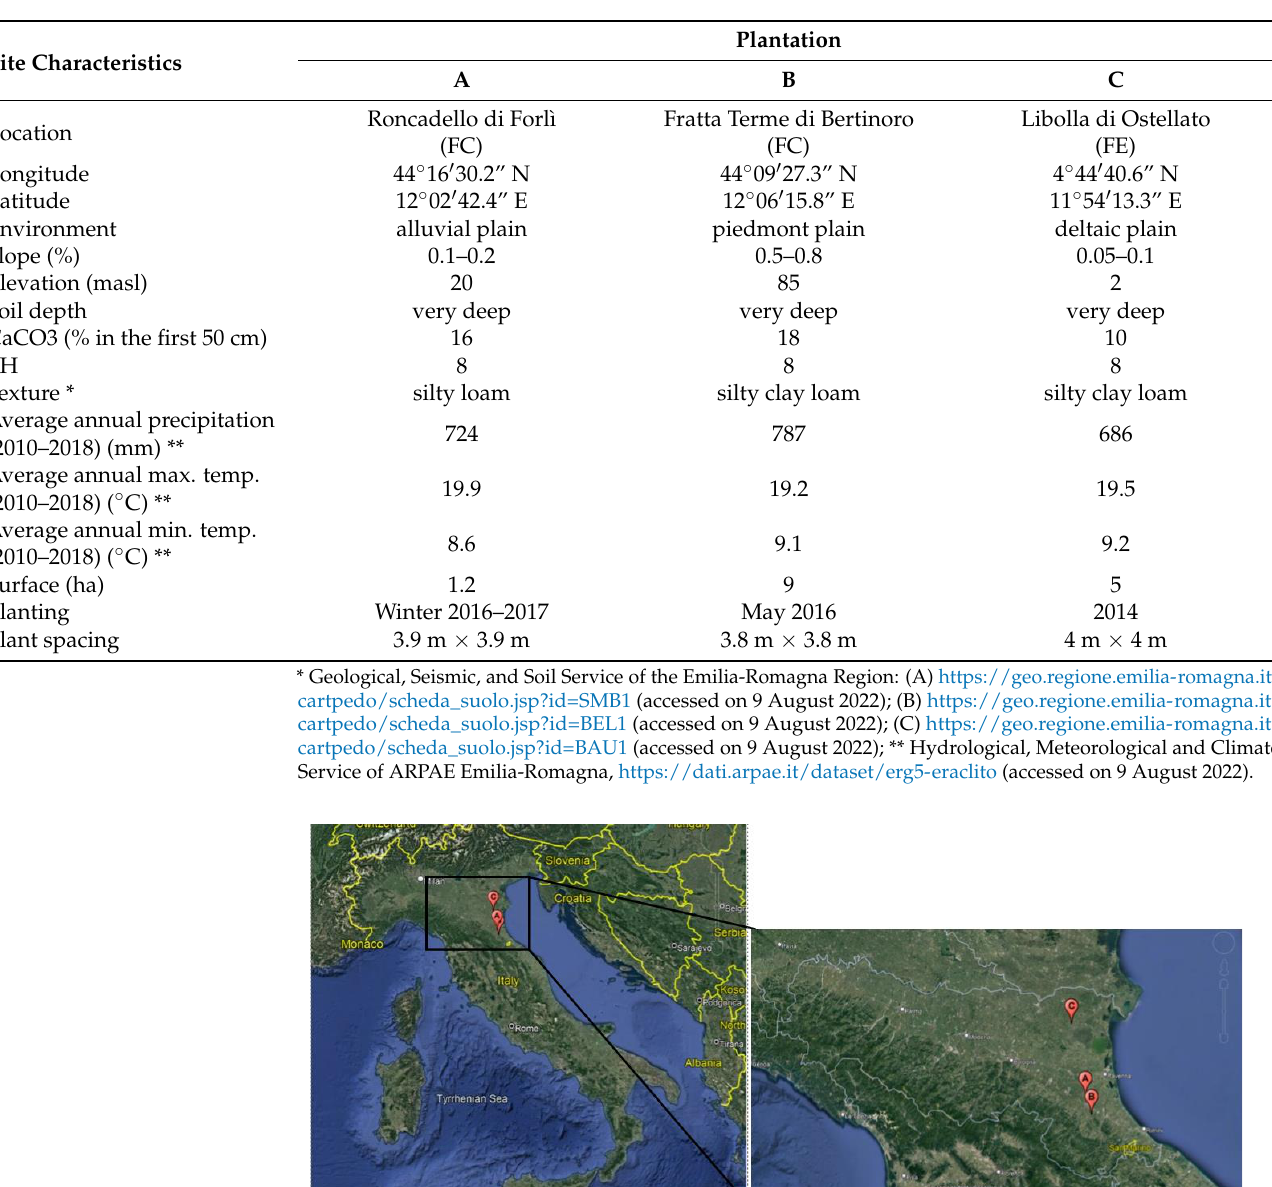
Table 1. Characteristics of the experimental areas.